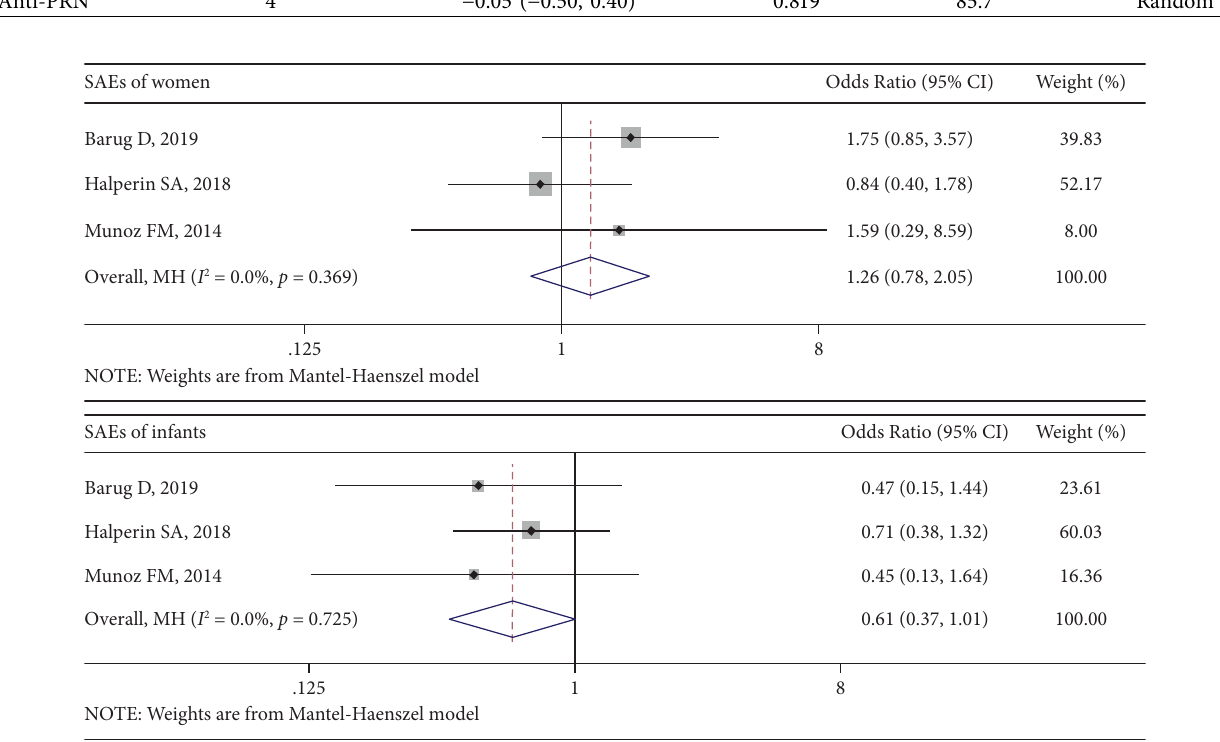
Figure 3: Forest plots of SAEs of women and